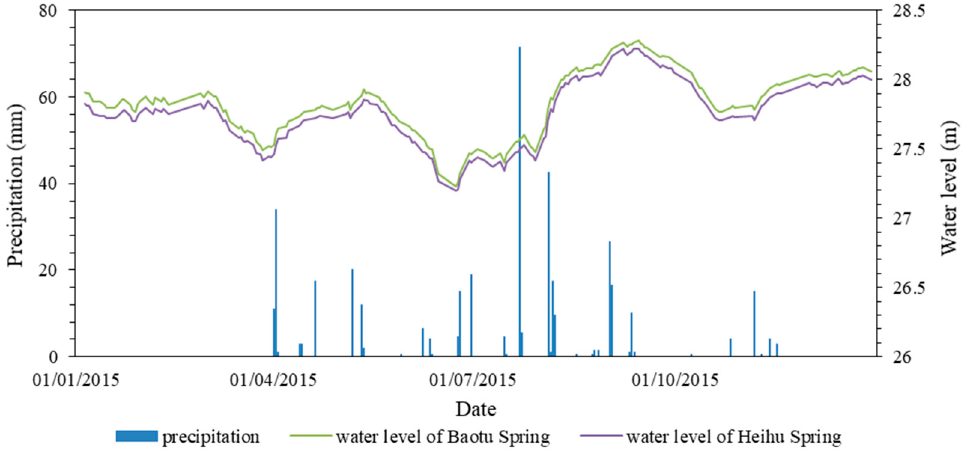
Figure 2. The plot of daily water levels of Baotu Spring and Heihu Spring, monthly precipitation, and monthly water flow of Yufu River in 2015.